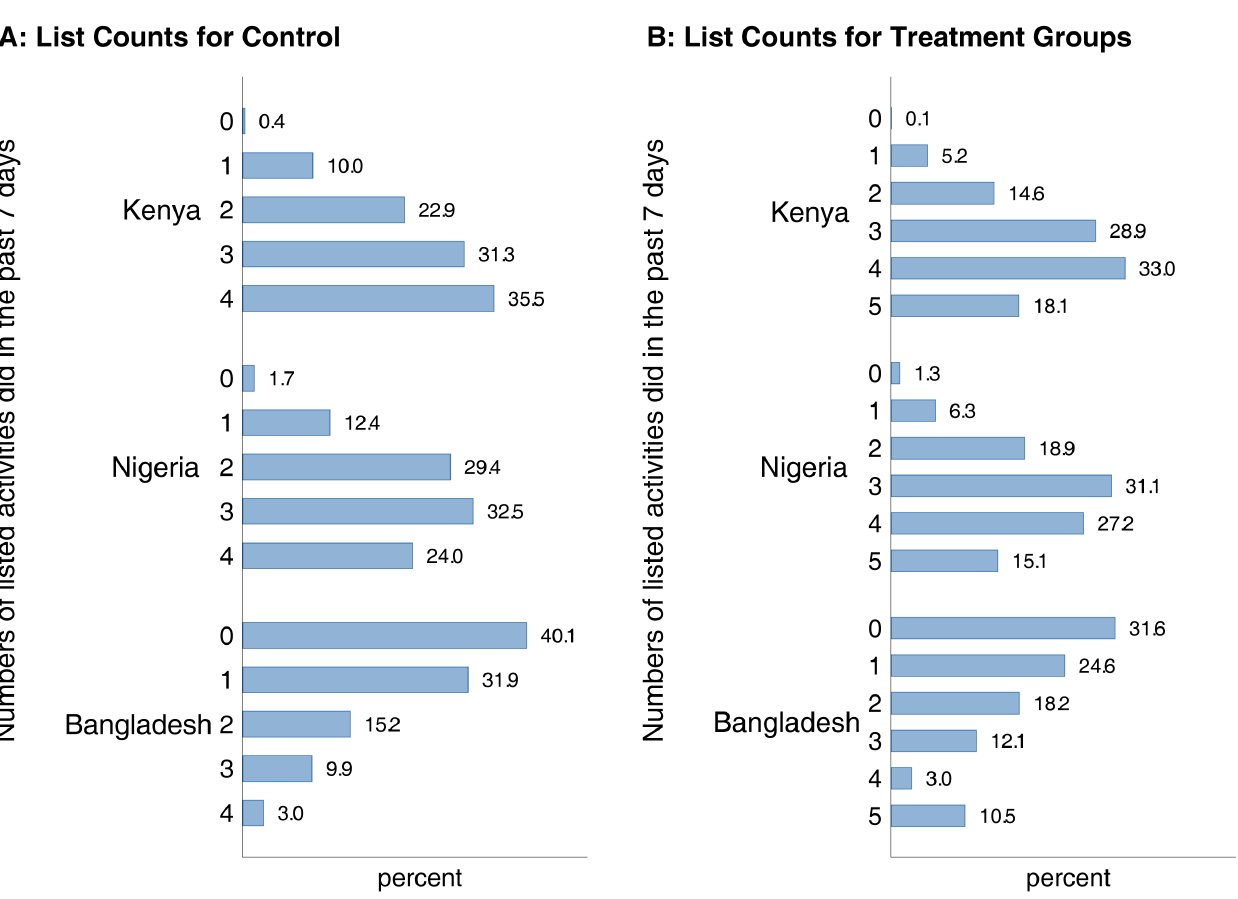
Fig 2. Self-reported number of listed activities, by treatment vs. control groups. Notes: Authors’ calculations from phone survey data from Kenya (N = 1647), Nigeria (N = 1608), and Bangladesh (N = 1722). The questions and designs of the list experiments are described in Table A in S1 Appendix. The tabulations of the number of “yes” answers reflect country specific